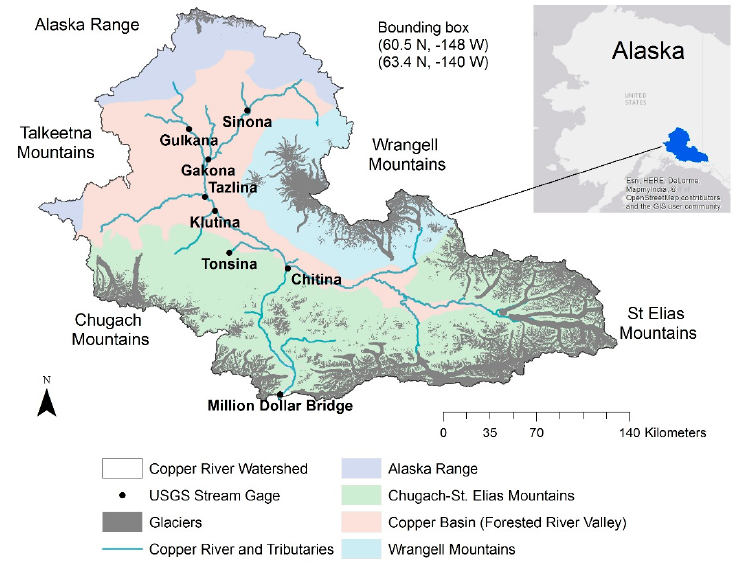
Figure 1. Site map showing the Copper River watershed, locations of glaciers, the river and its tributaries, four ecoregions, mountain ranges, and USGS stream gauges. The watershed outlet is at the Million Dollar Bridge.